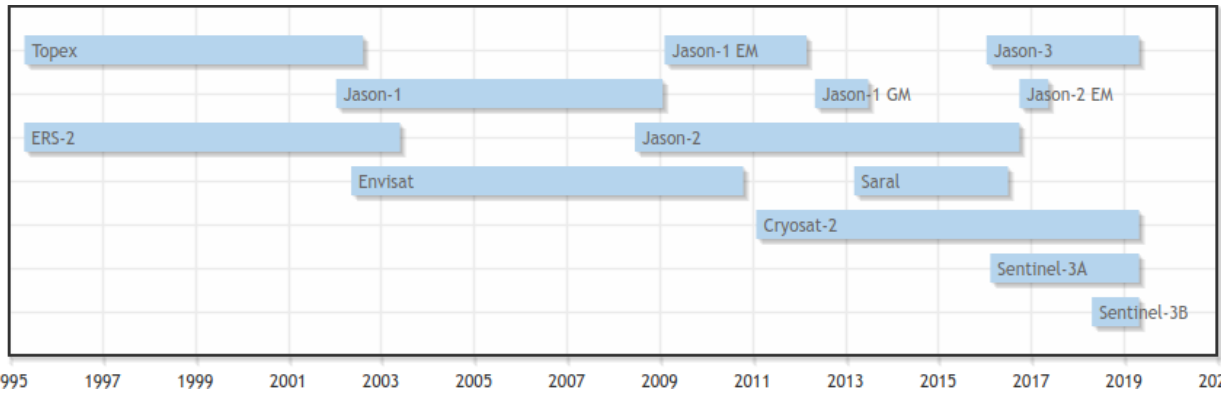
Figure 1. Satellite altimetry missions used in this